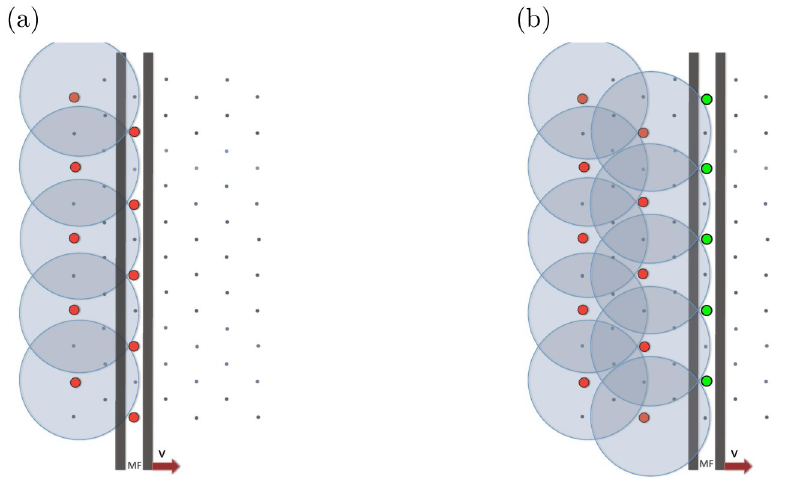
Fig 2. Visualization of the foundations of the R8 cell specification mechanism in the Drosophila eye disc. Simplified illustration of pattern formation mechanism in the Drosophila eye disc as a result of the competition between short-range inhibitor and long-range activator morphogens. Posterior region of the eye disc with an initial row of differentiated precursor cells, denoted by red dots. The morphogenetic furrow (MF), modeled by a plane wave front, moves to the right towards the anterior region. The gray circles represent the boundaries of regions affected by the short-range inhibitor, where the morphogenetic furrow (MF) will not initiate production of atonal . Therefore differentiation can only occur in those locations which are not affected by the short-range inhibitor, leading to the hexagonal supper-lattice of differentiated R8 cells, which is experimentally observed. This diagram does not incorporate cluster